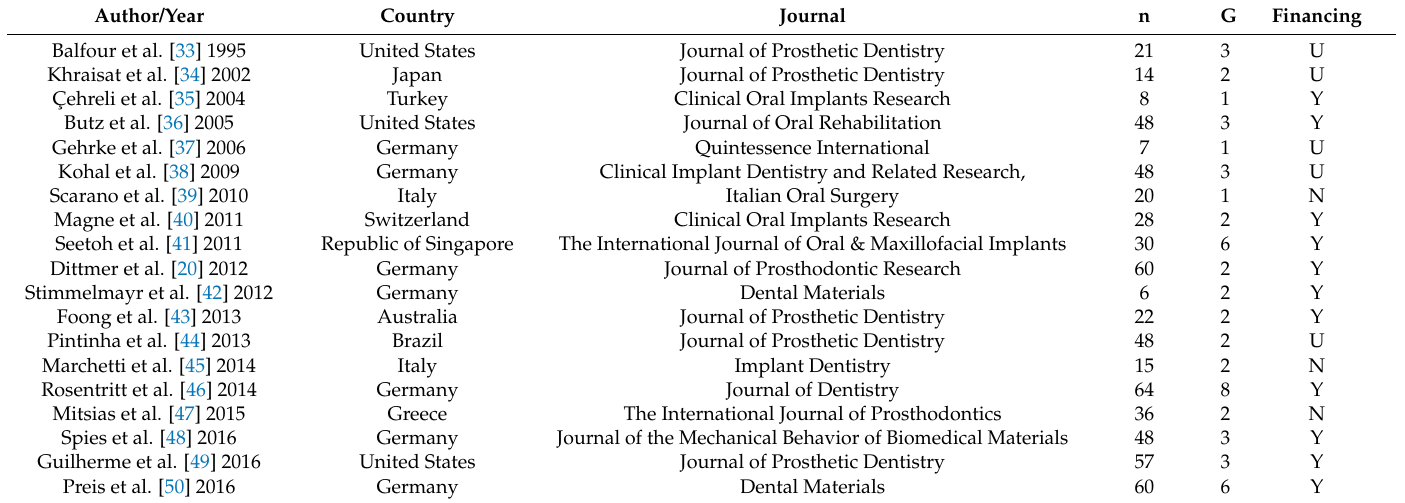
Table 2. Main characteristics of the included studies.